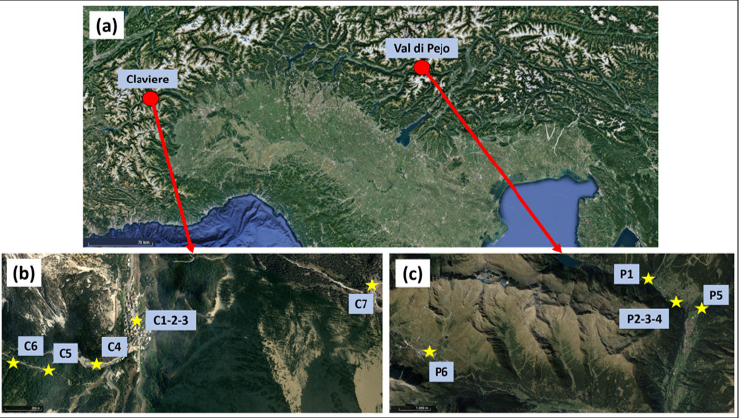
Figure 1. ( a ) Sampling locations; ( b ) Claviere samples; ( c ) Val di Pejo samples.